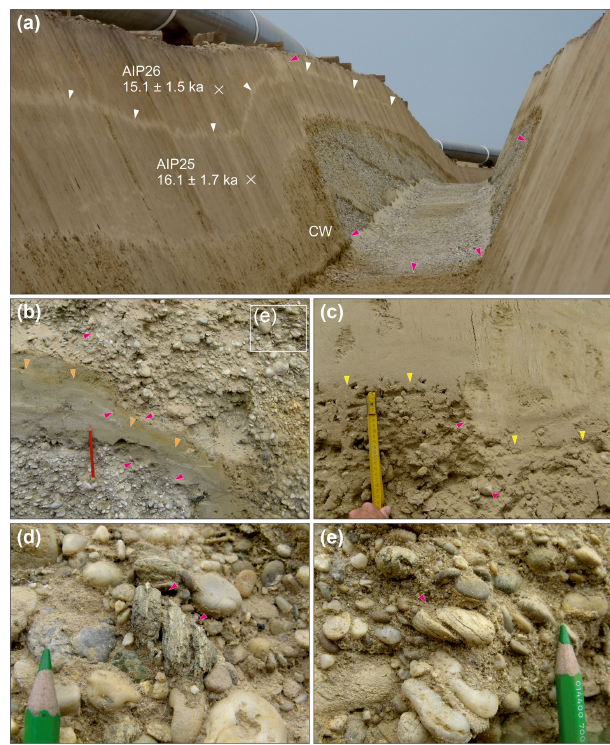
Figure 10. (a) Trench WAG looking NW toward the footwall of the MF (fault trace denoted by red arrows). Note offset of bright layer of loess (white arrows) corresponding to C1. CW denotes the col- luvial wedge related to earthquake C2. (b) Detail of the SW-facing trench wall. Red arrows denote locations of faults, while orange ar- rows point to the offset contact between grey and brown silt and clay. Box shows location of details shown in panel (d) . (c) Offset of the top of the colluvial wedge associated with earthquake C2 (yel- low arrows). (d, e) Fractured and sheared pebbles indicating normal displacement parallel to the slip of the MF. Note that fractures in pebbles are filled with sandy matrix excluding fracture formation during construction